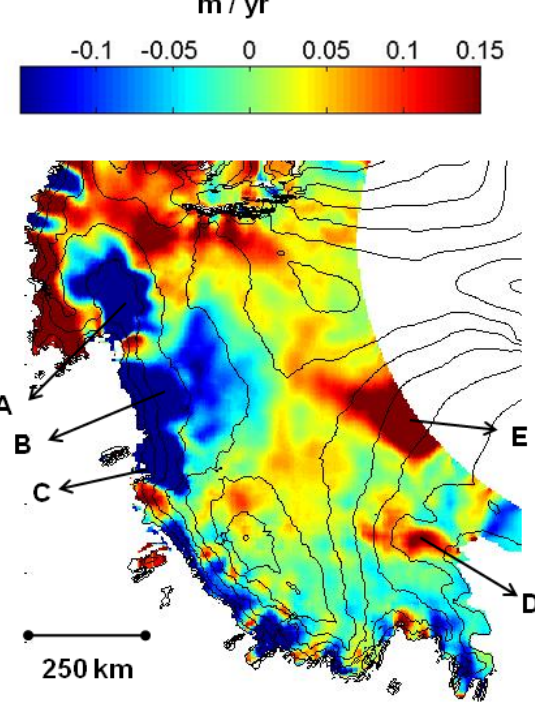
Figure 9. Enlargement of the changes in height in the west Antarctic ice sheet during the period 2002–2008. The Pine Island, Thwaites and Smith Glaciers sectors (noted A, B, C) decrease at a rate greater than − 0.15 m/yr while other glaciers (D or E) increase during this period. D is found to thinning only during the Envisat period, this shows that the upslope signal is propagated in few years over several hundred kilometres. E corresponds to the upslope part of the Kamb ice stream that flows out of the Envisat coverage. Its thinning up to the coast is confirmed with the IceSat data